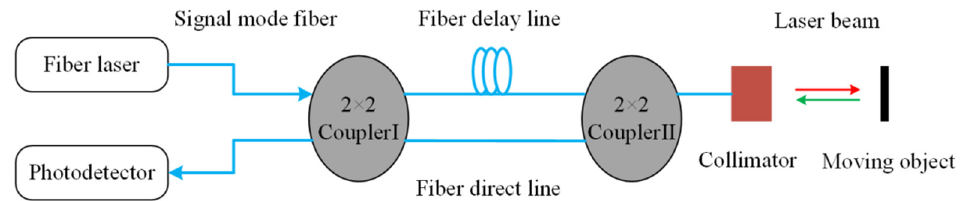
Figure 10. Optical configuration of an AFVISAR system.